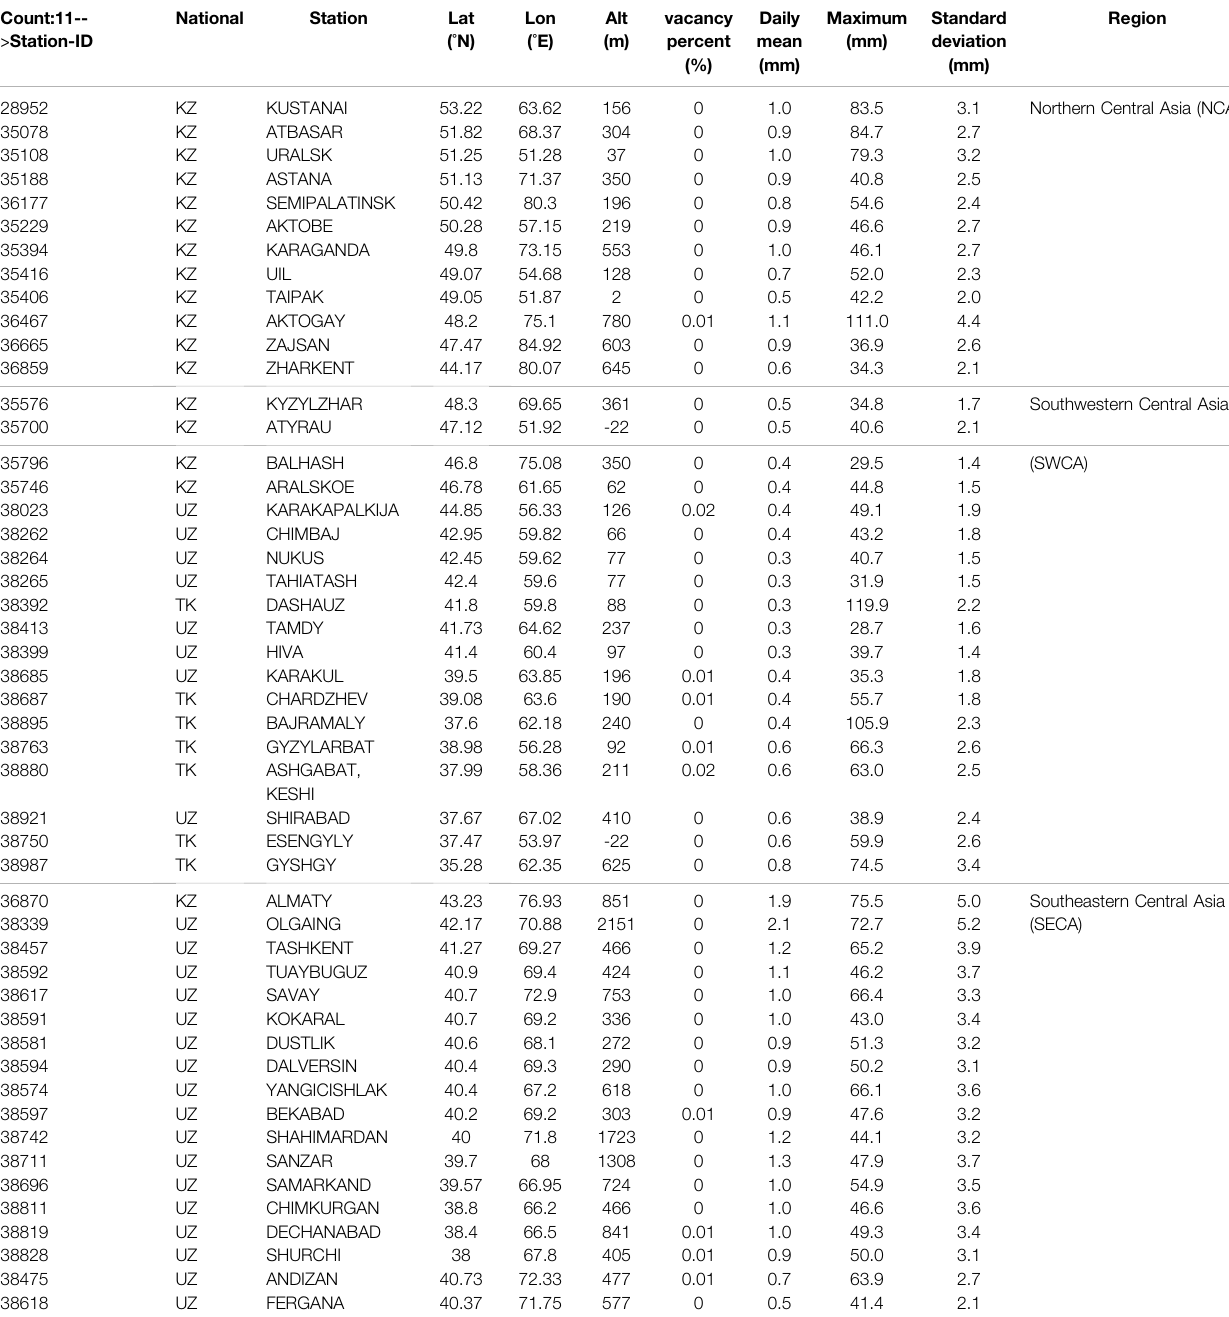
TABLE 1 | Geographical locations and altitudes of the 49 rain gauge stations used in this study. Count:11-- >